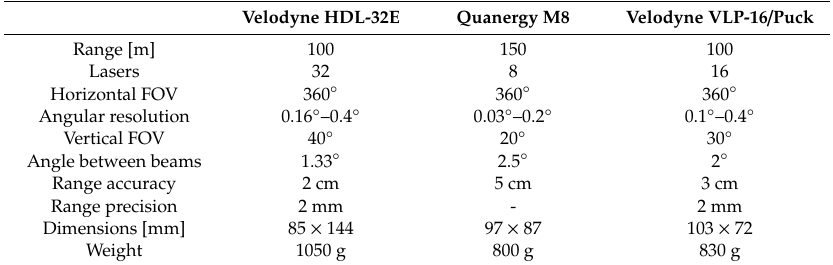
Table 1. UAS-mounted LiDAR scanners and specifications, including the Velodyne HDL-32E and Quanergy M8 sensors used in this study; the Velodyne Puck information is included for comparison purposes only (adapted from Pilarska et al. 2016 [14]).